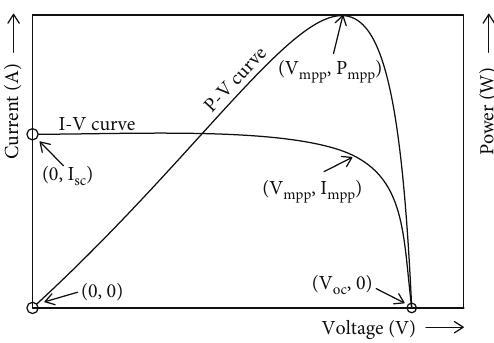
Figure 2: Characteristic I-V and P-V curve.